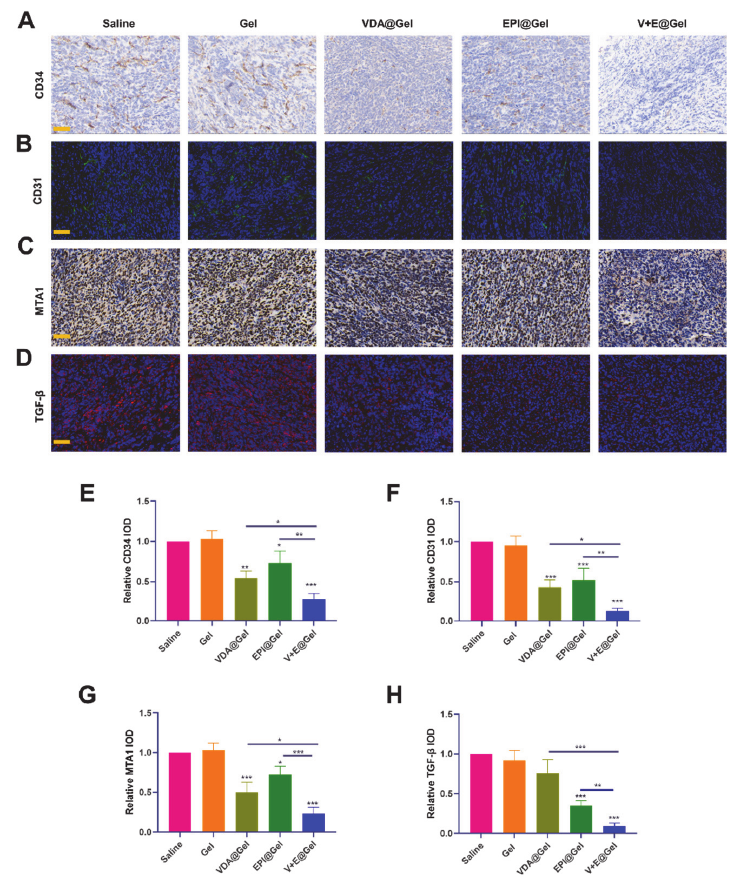
Figure 3. Anti-metastasis efficacy of V+E@Gel. Expression of ( A ) CD34, ( B ) CD31, ( C ) MTA1 and ( D ) TGF- β in tumor slices from each treatment group, scale bar = 50 µ m; Semi-quantitative analysis of ( E ) CD34, ( F ) CD31, ( G ) MTA1 and ( H ) TGF- β expression in tumor slices from each treatment group. All data are shown as mean ± S.D. ( n = 3), * p < 0.05, ** p < 0.01, and *** p < 0.001 vs. Saline.